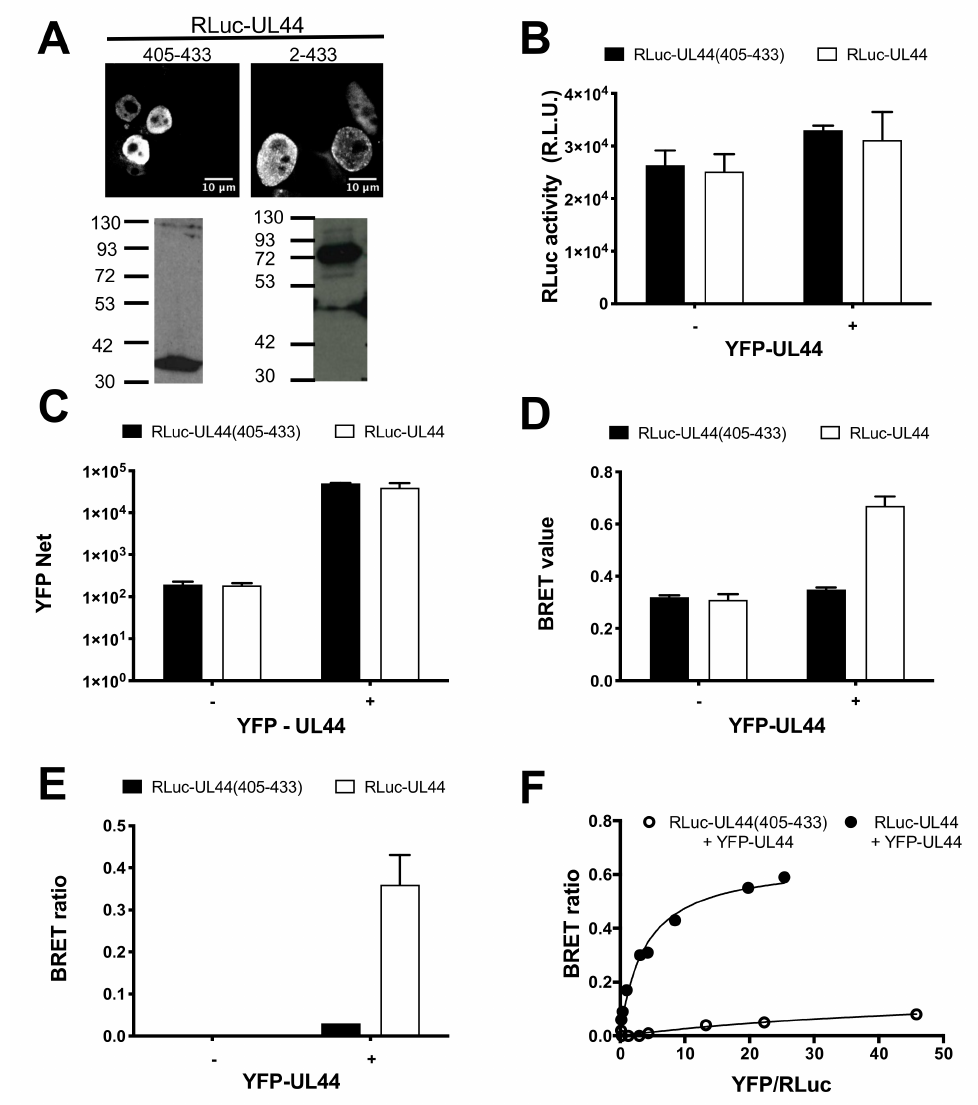
Figure 3. Bioluminescence resonant energy transfer (BRET) analysis of UL44 self-interaction in living cells. HEK293T cells were transfected to transiently express either RLuc-UL44(2–433) or RLuc- UL44(405–433), either in the absence or in the presence of YFP-UL44; 48 h later cells were processed for immunofluorescence and Western blotting ( A ) or BRET measurements ( B – F ) as described in the Materials and Methods section. ( A ) Subcellular localization and molecular weight of Renilla luciferase (RLuc)-fusion proteins was assessed using a mouse monoclonal antibody against RLuc. For BRET assays, RLuc activity ( B ) and YFP fluorescence ( C ) were measured, and the BRET value ( D ) and BRET ratio ( E ) were calculated. Representative data from two independent experiments performed in triplicate are shown. ( F ). The BRET ratio relative to indicated BRET pairs is plotted against the ratio between YFPnet and RLuc emission as described in the Materials and Methods section. Representative data from two independent experiments performed in triplicate are